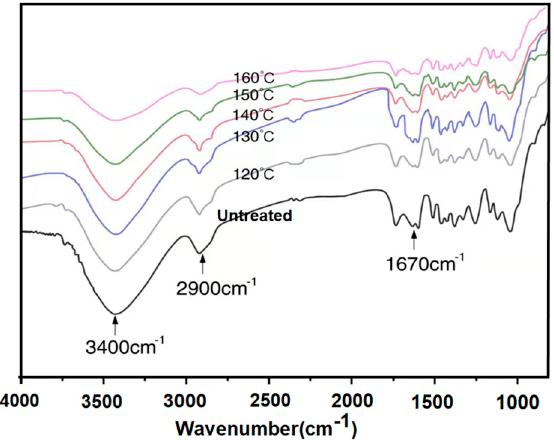
Figure 2. FTIR spectra for bamboo samples.